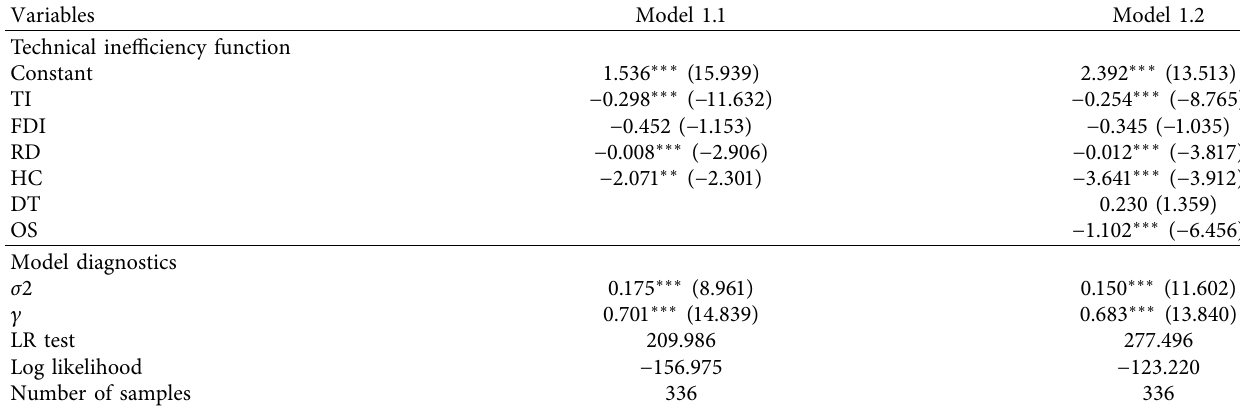
Table 3: Estimation results when considering environmental pollution.